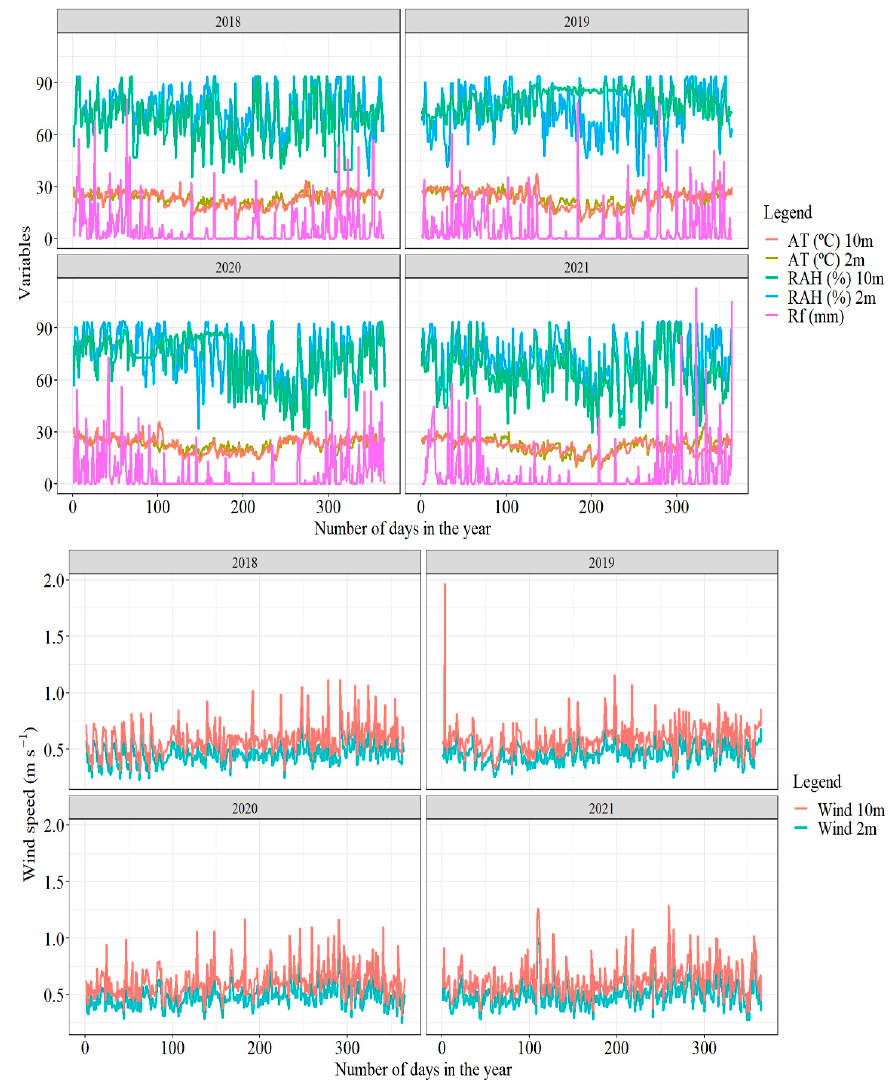
Figure 3. Temporal distribution of daily micrometeorological data during the years 2018–2021 for the 10 m and 2 m levels in Itatiaia National Park, Brazil. AT = air temperature (°C); RAH = relative air humidity (%); Rf = rainfall (mm)—automatic station A635; Wind = wind speed (m s − 1 ).